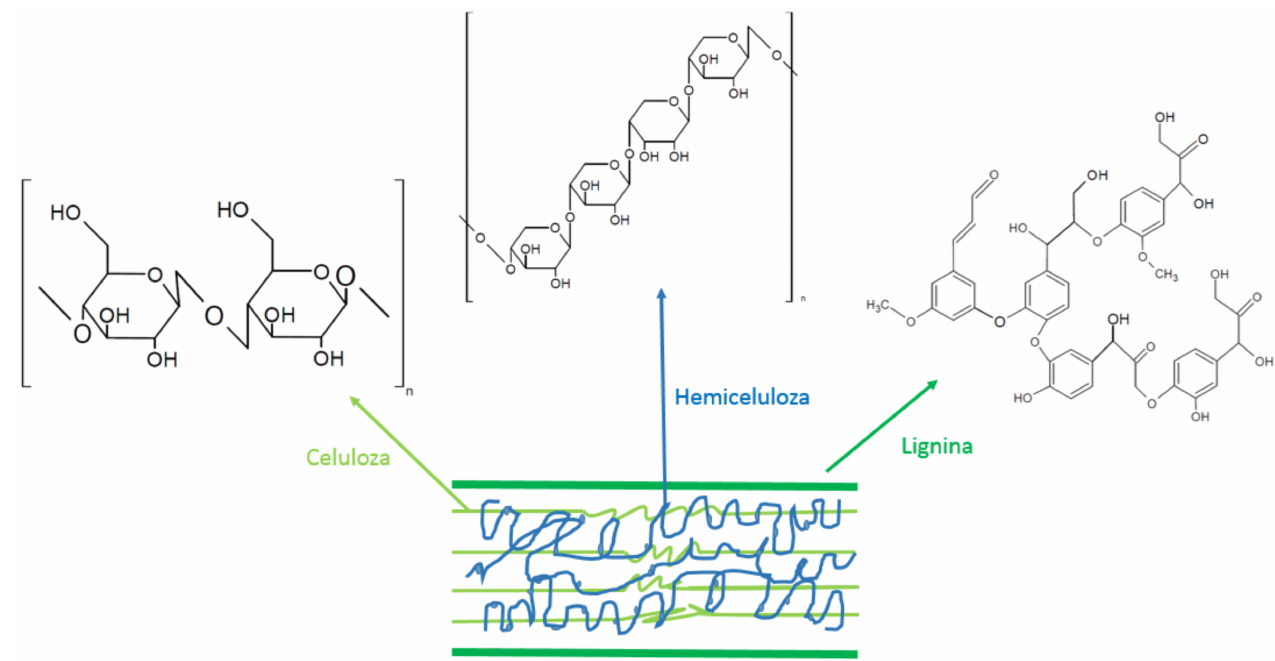
Figure 4. Chemical composition of plant